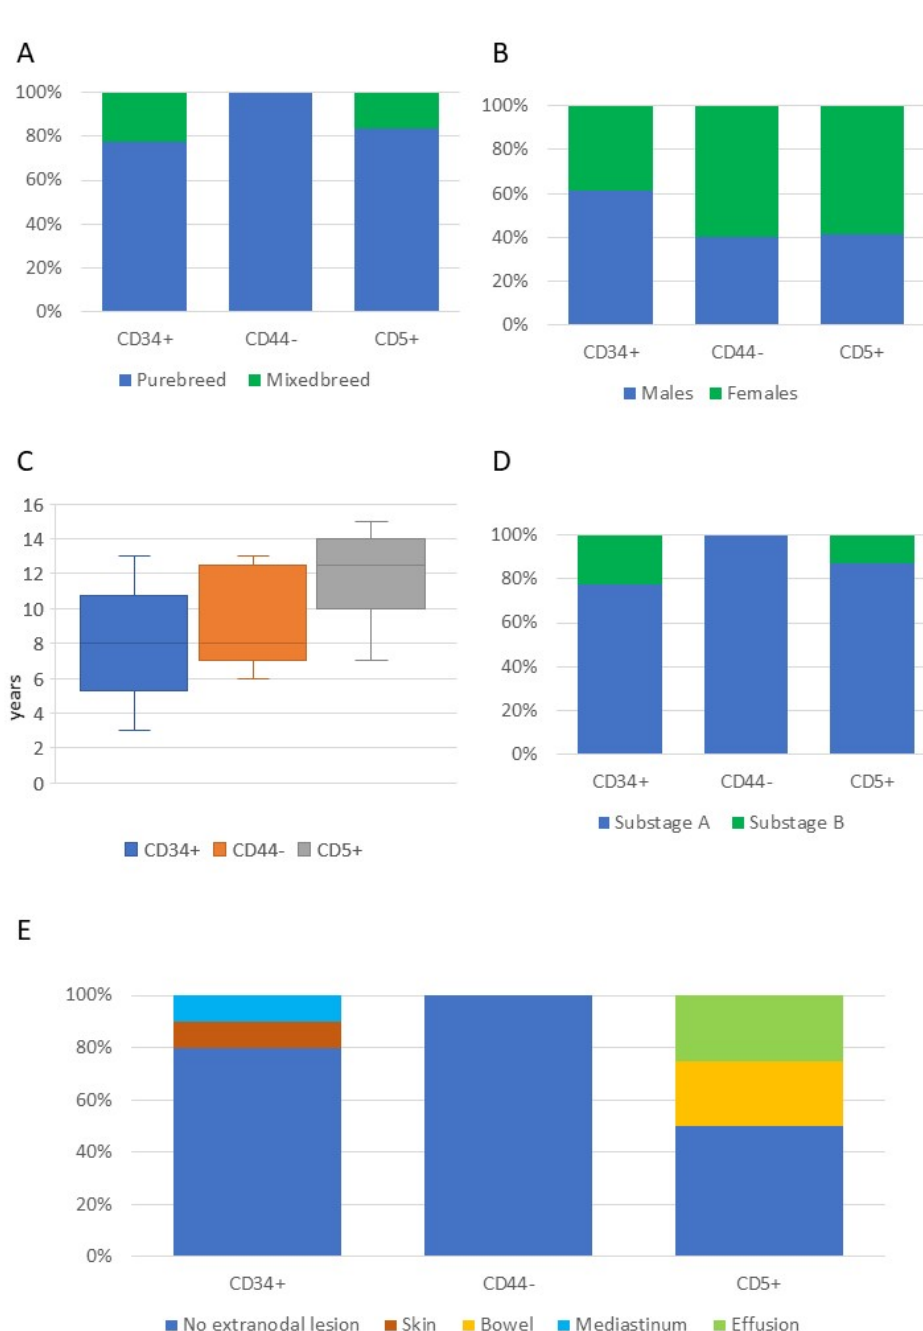
Figure 3. Breed ( A ), sex ( B ), age ( C ), substage ( D ), and presence of extranodal lesions ( E ) in 54 dogs with B-cell lymphoma, according to the three most common phenotypic aberrancies.